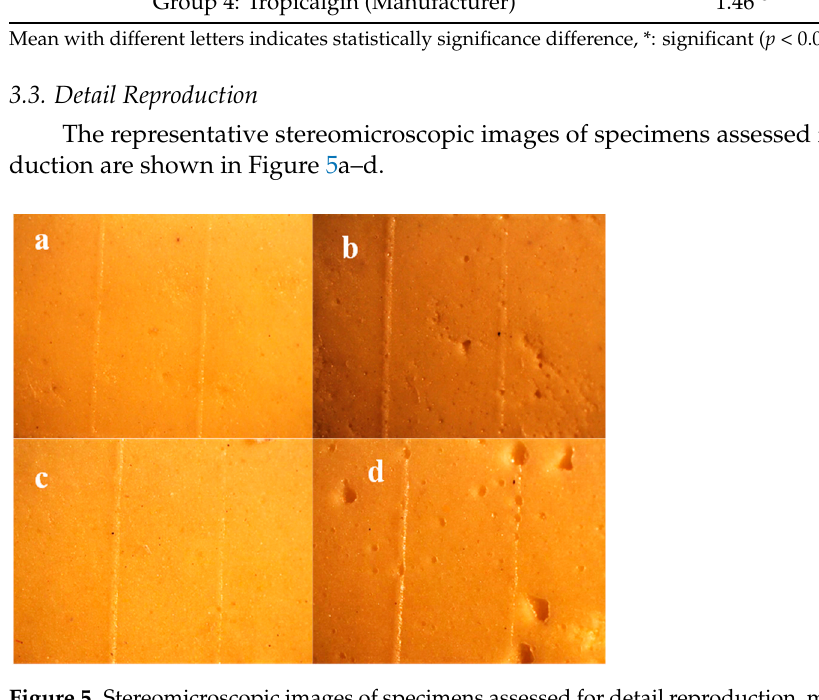
Figure 5. Stereomicroscopic images of specimens assessed for detail reproduction, magnification 10×: ( a ) Group 1 (Algistar mixed as Manufacturer), ( b ) Group 2 (Algistar with ↑ Powder/water ra- tio, ( c ) Group 3 (Tropicalgin with ↓ Powder/water ratio), ( d ) Group 4 (Tropicalgin mixed as Manu-